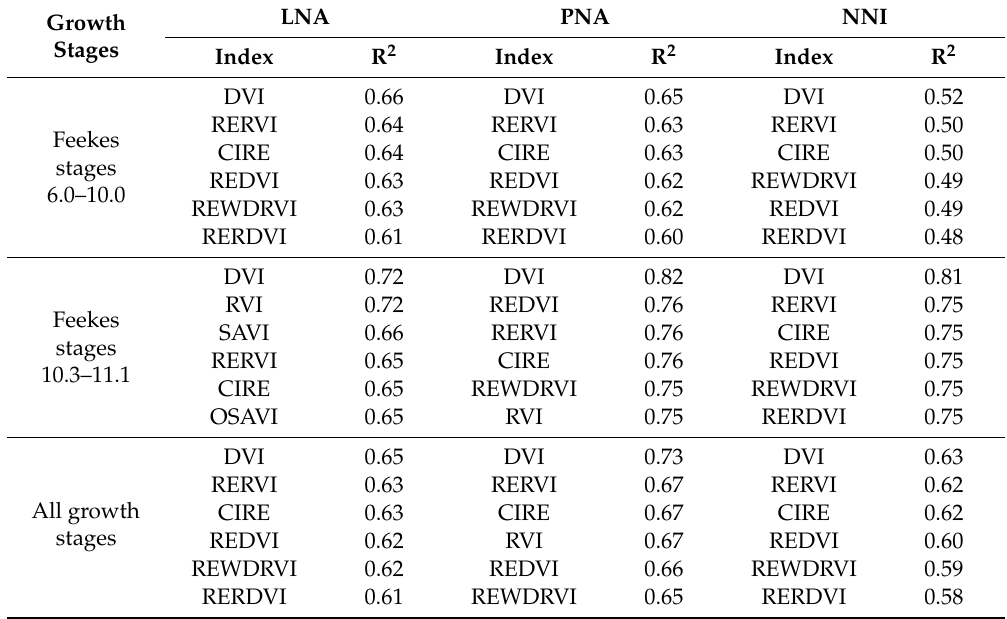
Table 5. Coe ffi cients of determination (R 2 ) for pair-wise associations between top 6 vegetation indices and leaf nitrogen accumulation (LNA), plant N accumulation (PNA) and nitrogen nutrition index (NNI) at di ff erent growth stages across varieties, sites (Sihong and Rugao) and years (2015–2017). The full name of each vegetation index was shown in Table